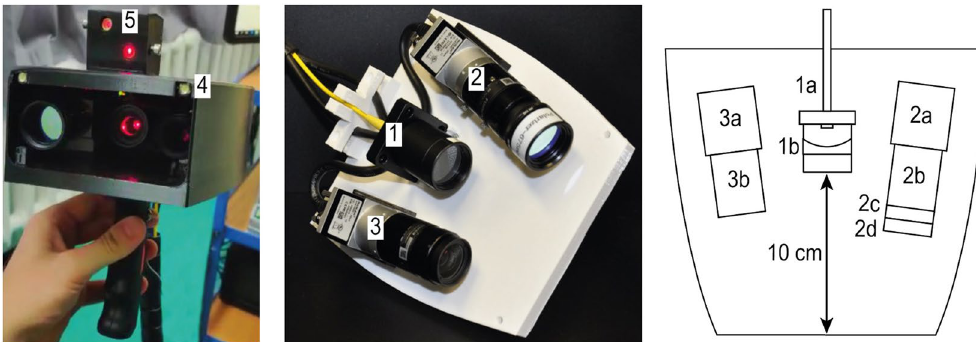
Figure 1. Experimental setup of the handheld perfusion imager (HAPI). Left, a front view of the handheld probe. Middle, handheld probe without a cap (reprinted from 18 ). Right, schematic drawing of the handheld probe. 1, Fiber tip (1a) and lens for laser beam expansion (1b). 2, Set of monochromatic camera (2a), objective lens (2b), bandpass filter (2c) and linear polarizer (2d). 3, Set of RGB camera (3a) and objective lens (3b).